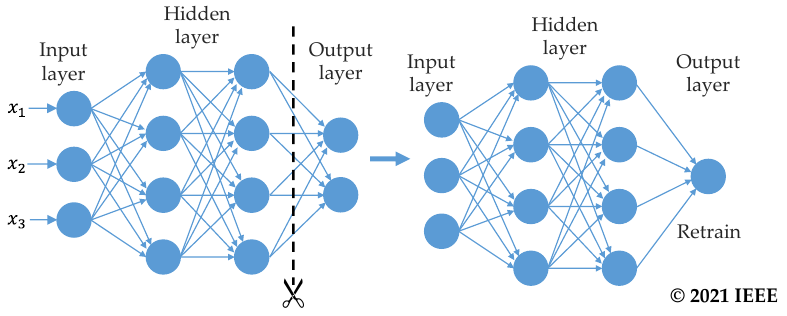
Figure 7. Transfer learning using feature extraction [30,31].